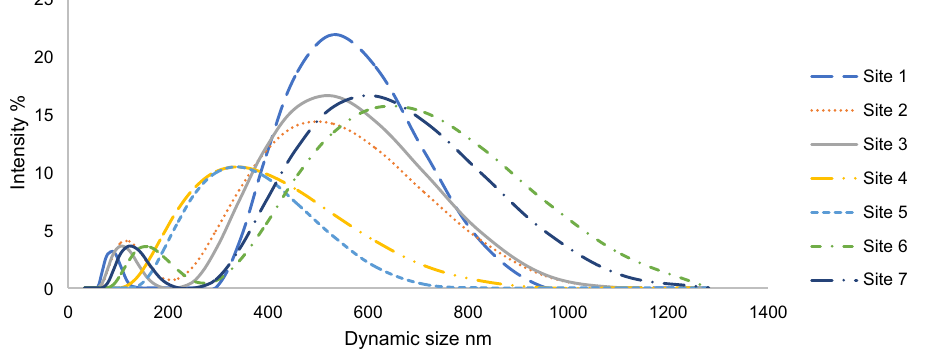
Figure 7. Particle size distribution (PSD) of colloidal particles in Bentong River